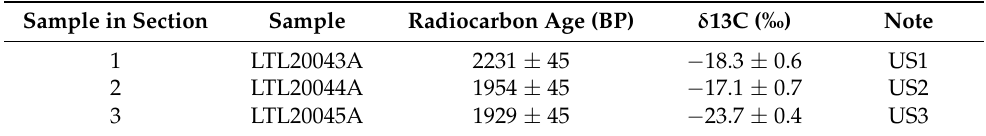
Table 4. Radiocarbon data of the outer overgrowth of Ustica stalactite. The Note column shows the sample name used in Figure